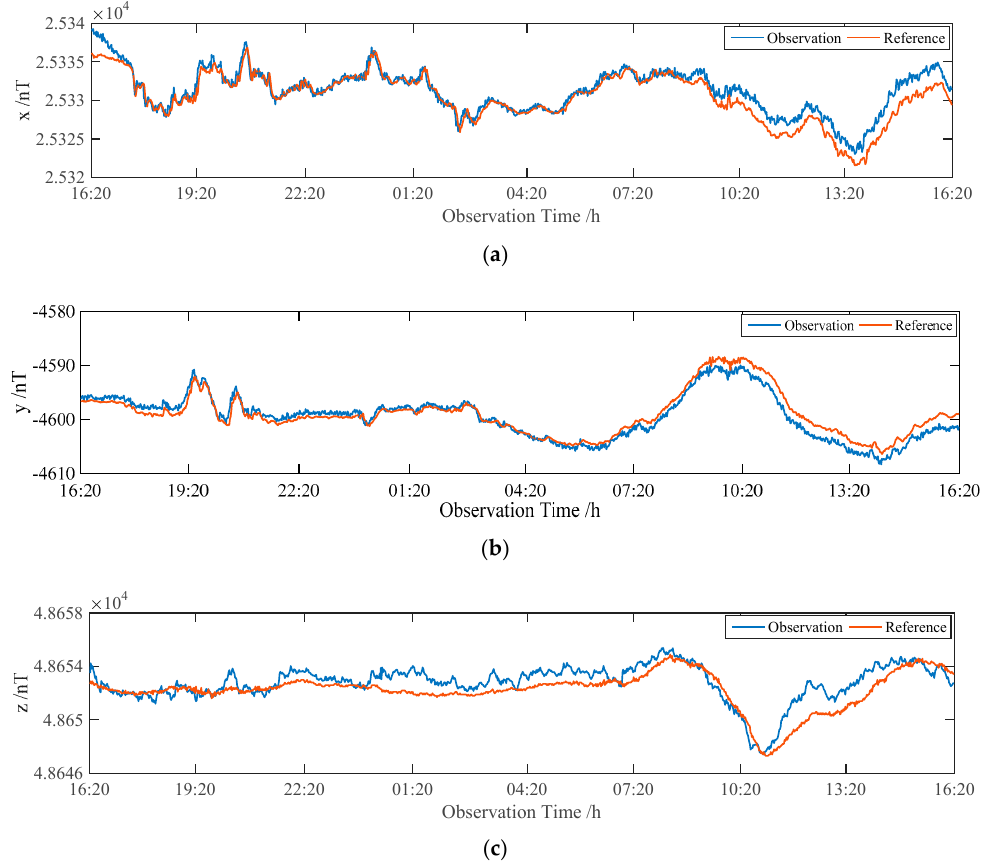
Figure 8. Diurnal variation observations. ( a ) The observed value of x -component; ( b ) The observed value of y -component; ( c ) The observed value of z